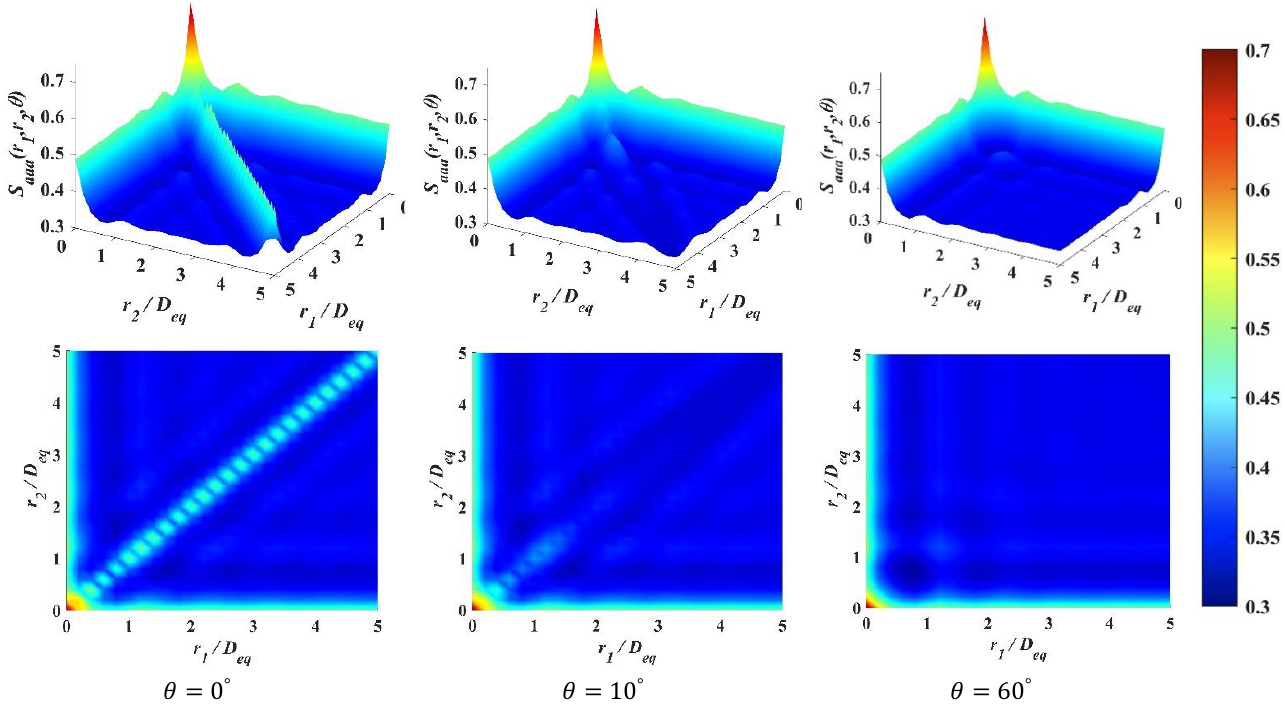
Figure 10. Illustration of 𝑆 𝑎𝑎𝑎 (𝑟 1 , 𝑟 2 , 𝜃) for regular squares with selected 𝜃 = 0 ° , 10 ° and 60 °